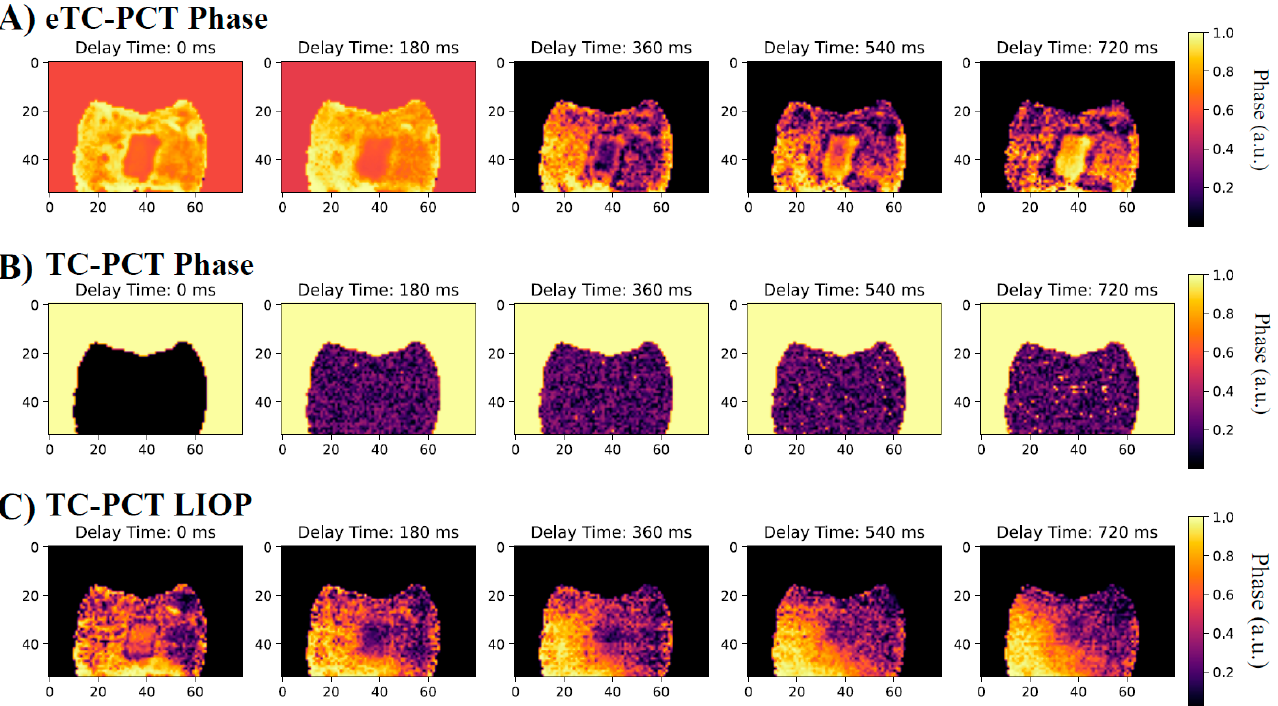
Figure 8. Select tomographic phase slices: ( A ) eTC-PCT phase, ( B ) TC-PCT phase, and ( C ) TC-PCT LIOP of the B8 sample lingual surface after 8 days of bacteria-induced demineralization. Their corresponding phase values were normalized between 1.0 and 0 by subtracting the minimum phase value and then dividing by the maximum phase value within each slice. All slices were calculated using the same data from a 0.2–0.6 Hz, 12 s chirp with 63 W peak laser power. Contrast of the slices has been enhanced using the slice-by-slice global histogram equalization algorithm described in software available online [13].